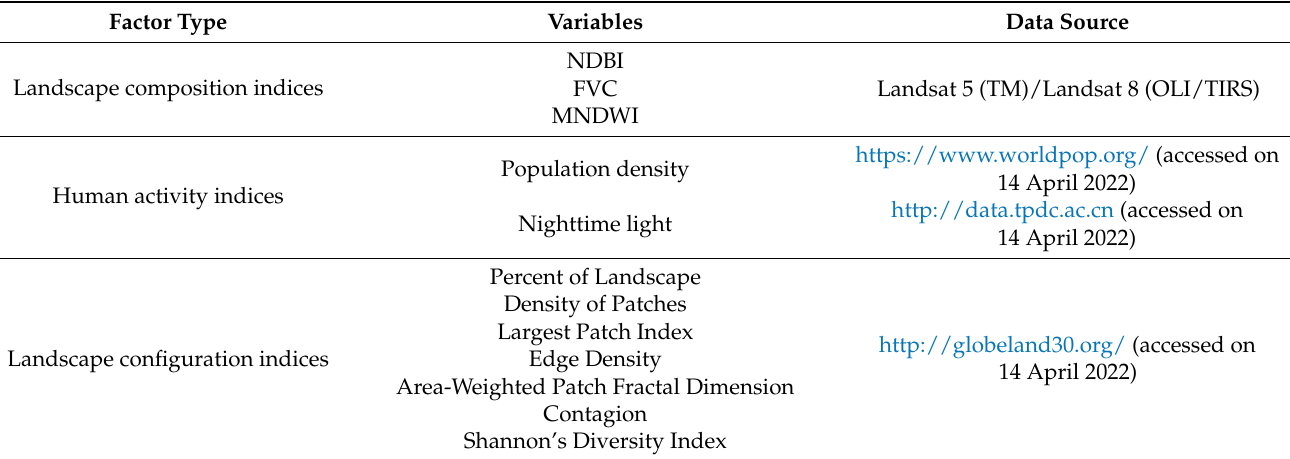
Table 1. The selected independent